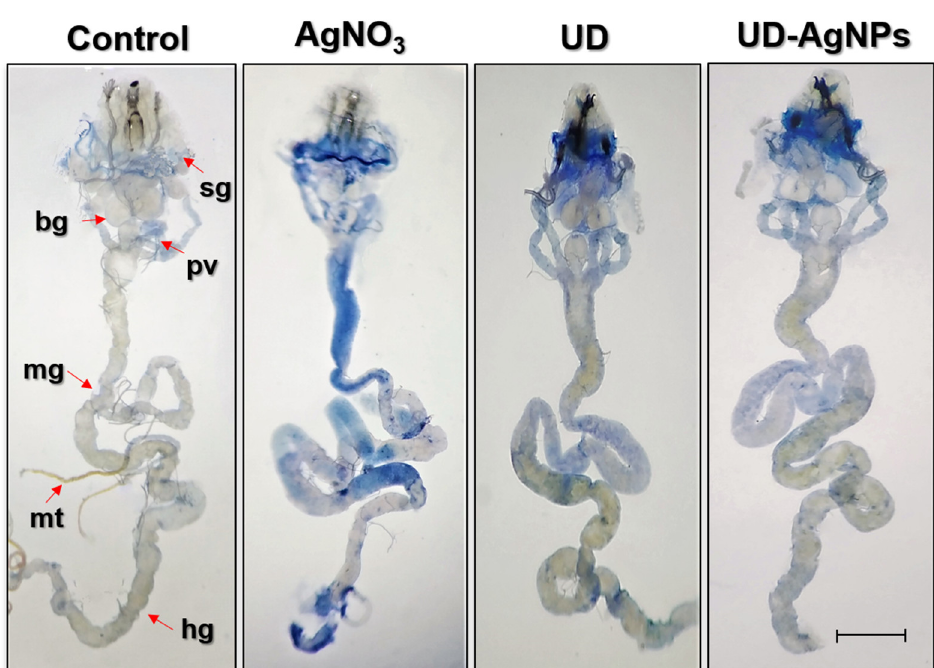
Figure 7. Dye exclusion test through trypan blue staining in dissected third instar larvae (Seventy-two hours old) of D. melanogaster (Oregon R + ) exposed to AgNO 3 , UD, and UD-AgNPs for 48 h. Note: bg = brain ganglia, pv = proventriculus, sg = salivary glands, mt = Malpighian tubules, mg = midgut, and hg = hind gut. The bar represents 100 µm. AgNO 3 = silver nitrate, UD = Urtica dioica, and UD-AgNPs = biosynthesized silver nanoparticles of Urtica dioica.